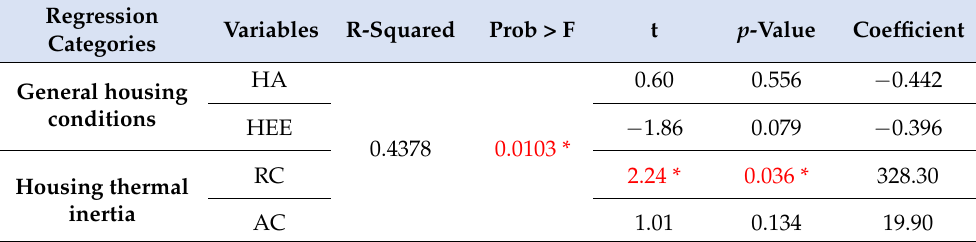
Table 5. Regression analysis results: heat-related emergency department visits (EDV).